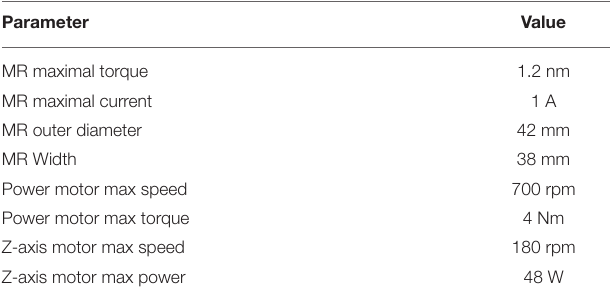
TABLE 2 | Performance of the drive